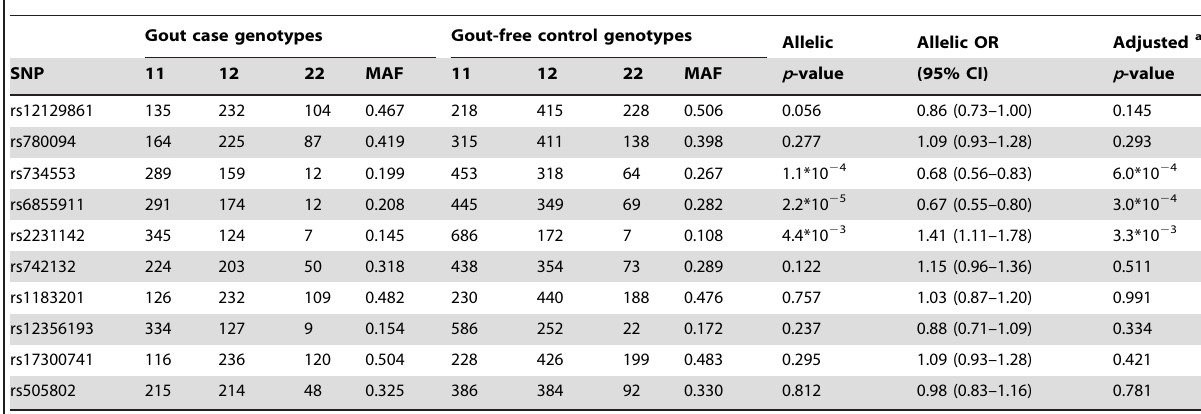
Table 5. Association analysis results in male gout case-control sample.